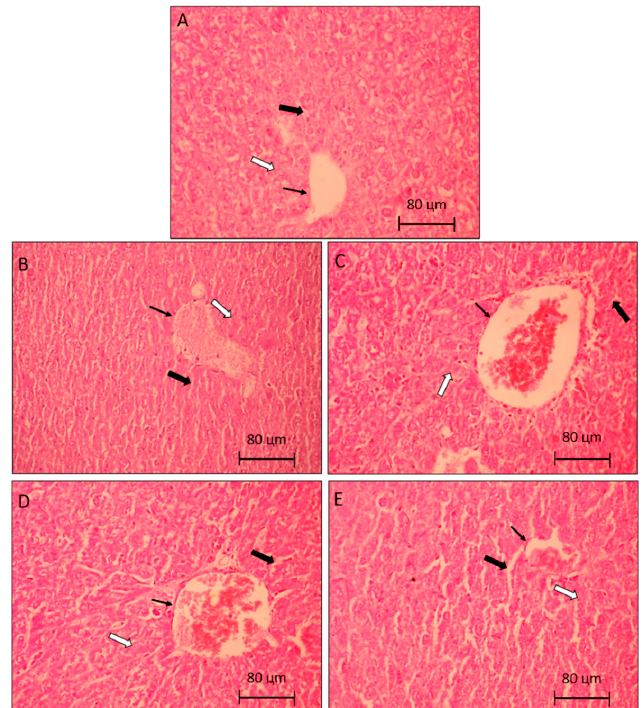
Figure 4. Photomicrographs representative of liver histology (5 µm). Control group ( A ), are animals without tumor S180 treated with the vehicle (saline). The control group ( B ), are animals with tumor S180 treated with the vehicle (saline). Group ( C , D ), are animals with S180 tumor treated with PaLE 100 and 150 mg/kg/day, respectively. The positive control group ( E ), are animals with S180 tumor treated with 5-FU 25 mg/kg/day. The thin arrows indicate centrilobular vein, hollow arrows: hepatic trabeculae, and full arrows: sinusoid. 400× magnification.